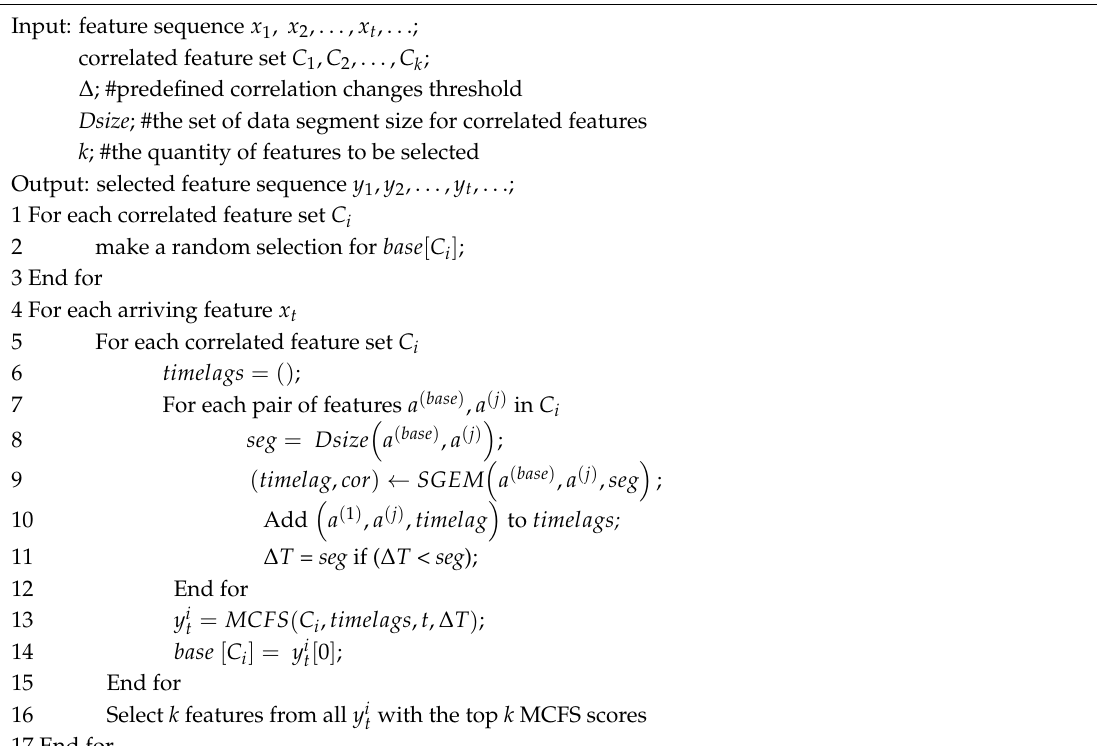
Algorithm 4. Feature selection based on feature